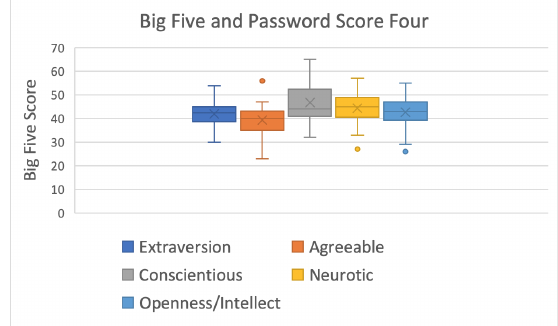
Figure 2. Big Five personality traits and password strength. This graph only includes zxcvbn password score four.